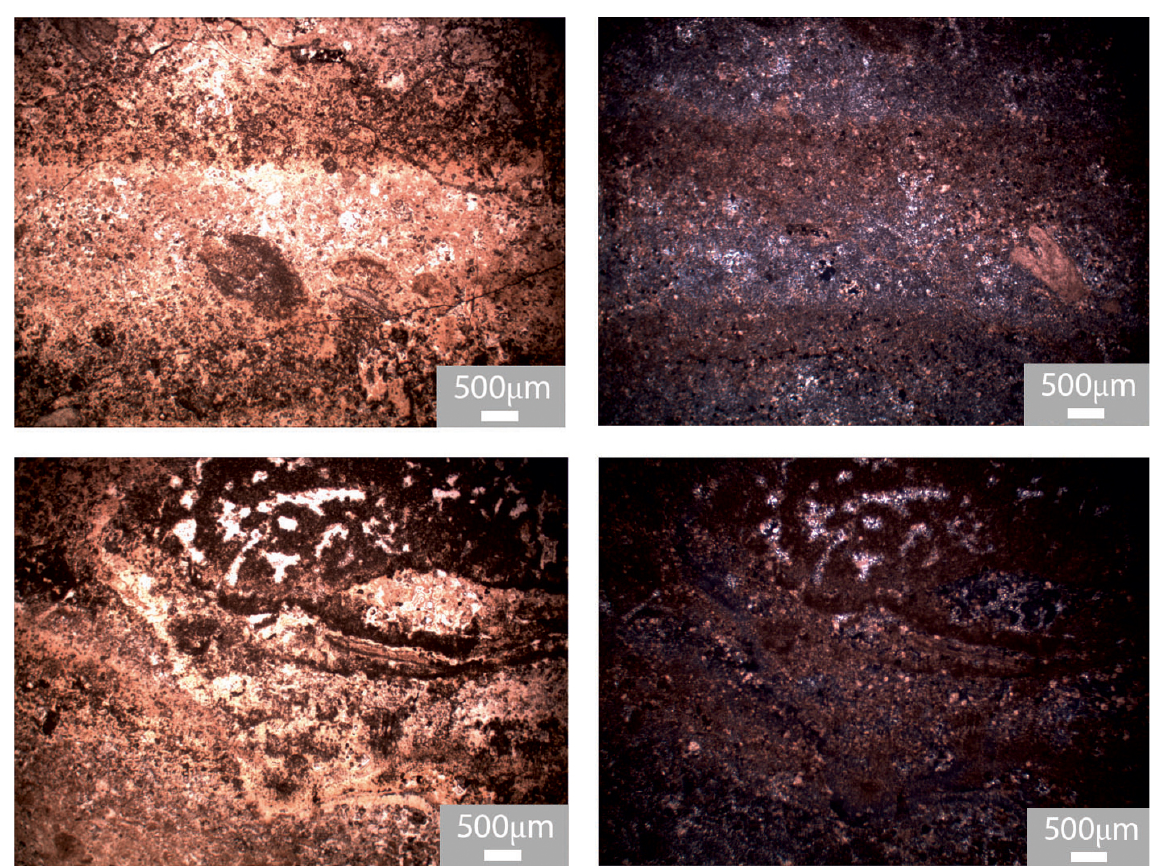
Figure 6. Thin section images of Vilaplana chert. Left: The laminated carbonate elements (Liesegang rings) create a packstone texture. Right: The samples in crossed polarised light reveal a differential siliceous content configuring the xyloidal